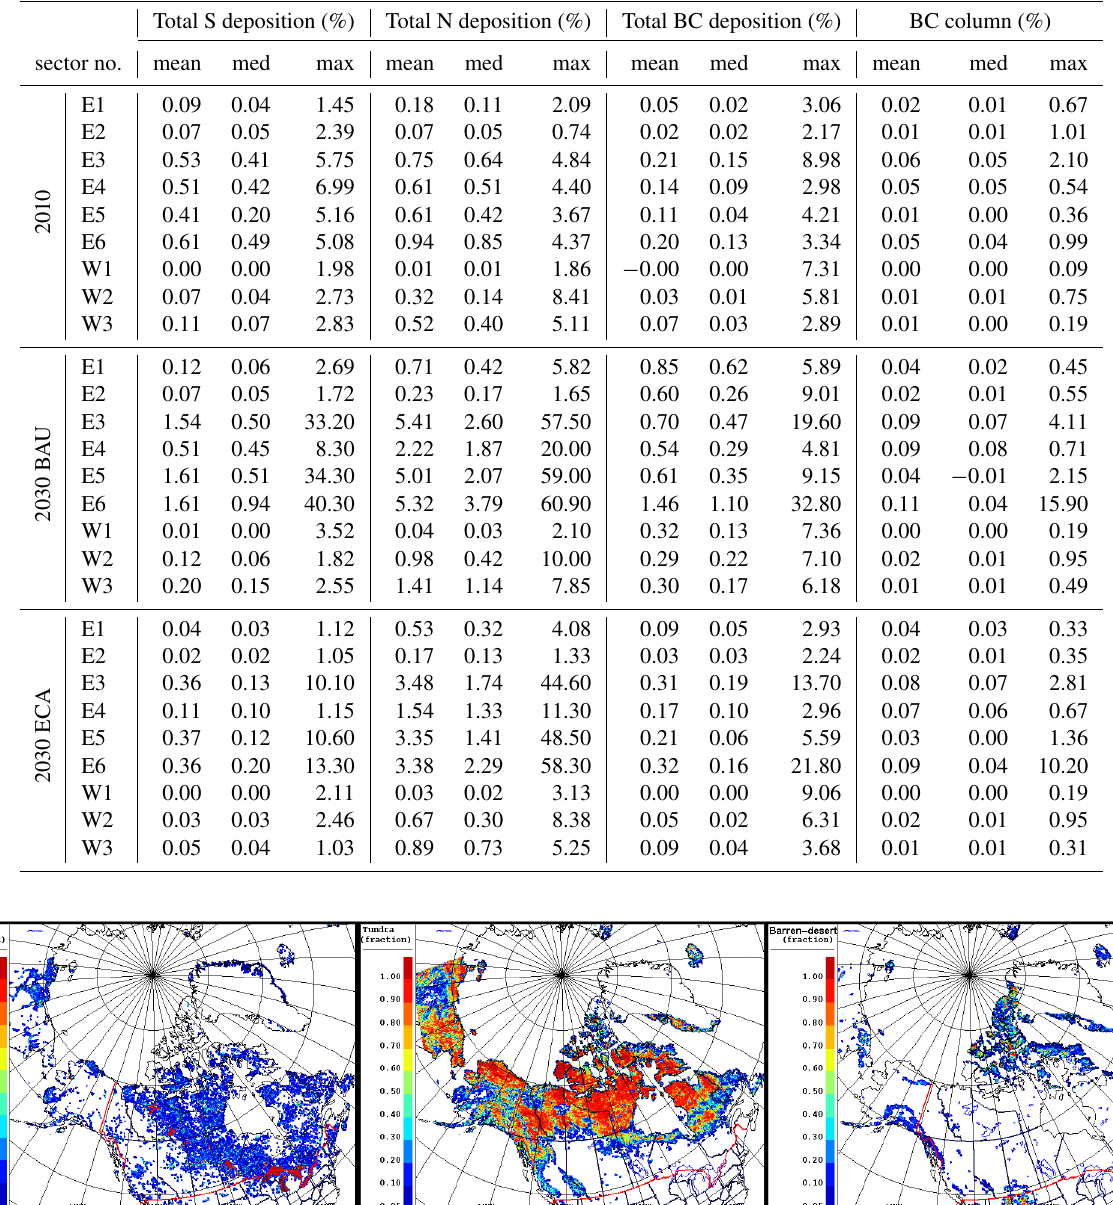
Table 8. Percentage contribution from Arctic shipping to surface depositions of sulfur, nitrogen, and elemental carbon (BC) and column loading of EC (BC), by geographical sectors (see Table 1), for the July–August–September period. Total S deposition (%)